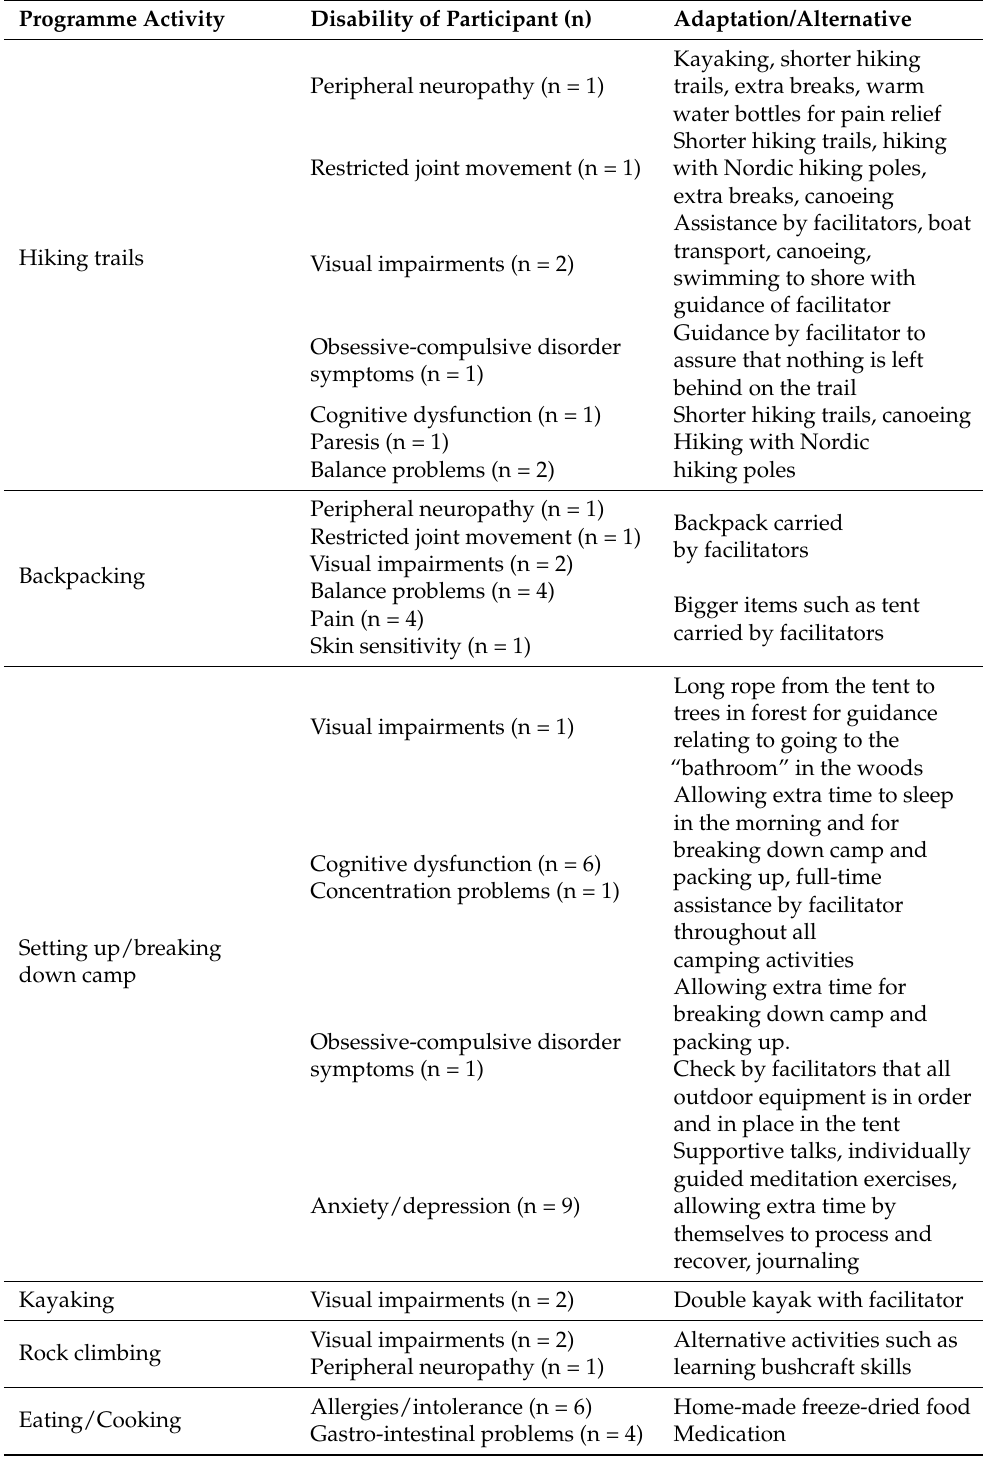
Table 5. Individual adaptation of the WAYA programme